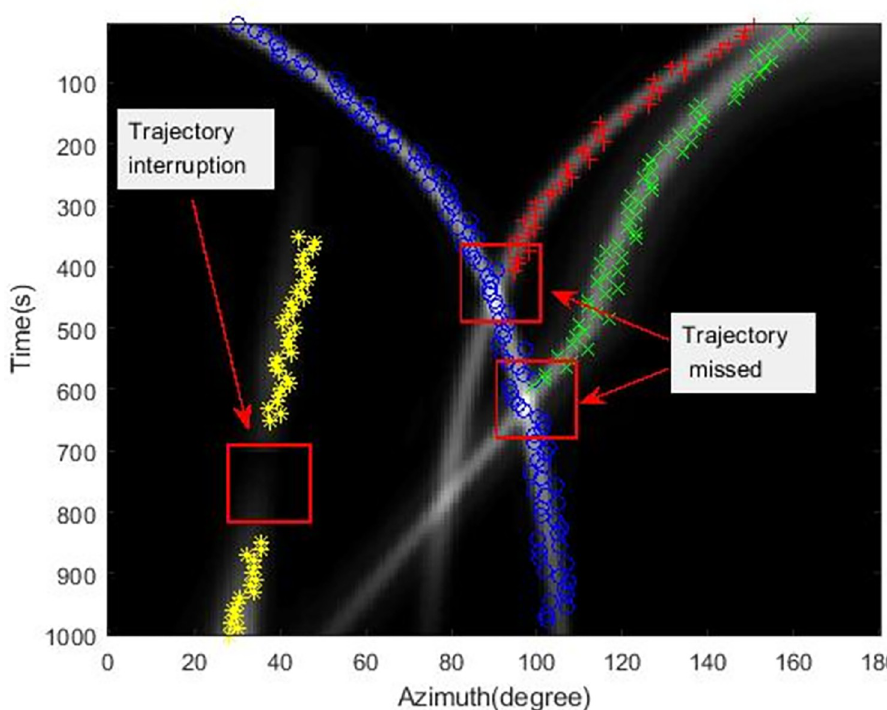
Fig 11. Simulation tracking results of the EKF-Max method.